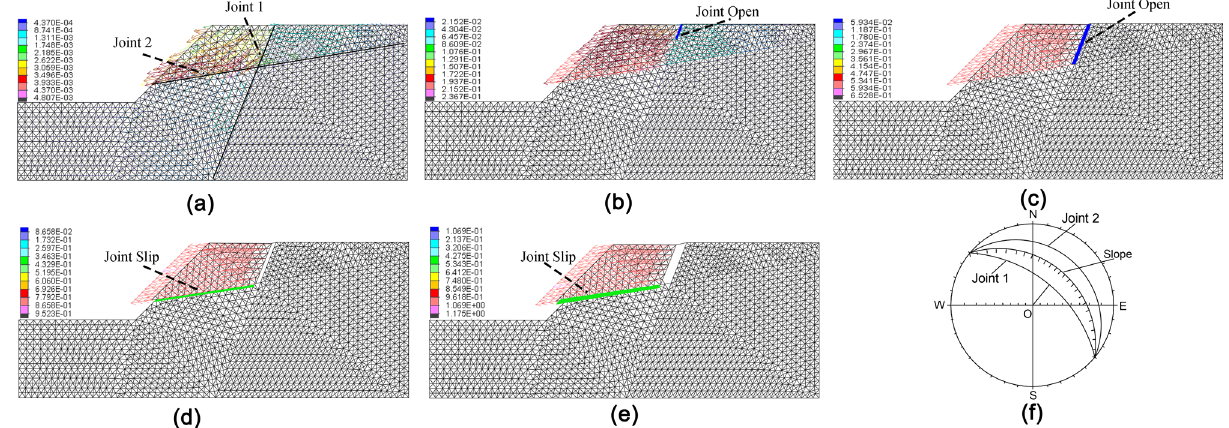
Figure 2. Five stages ( a – e ) of the development process of landslide simulated by UDEC. The colored vector indicates the displacement change (unit: m). The TRSS mode is formed in an ideal jointed rock slope. ( f ) Stereographic projection of the jointed slope system. We produced the figures using UDEC (Ver.6.0) software (https ://www.itasc acg.com/softw